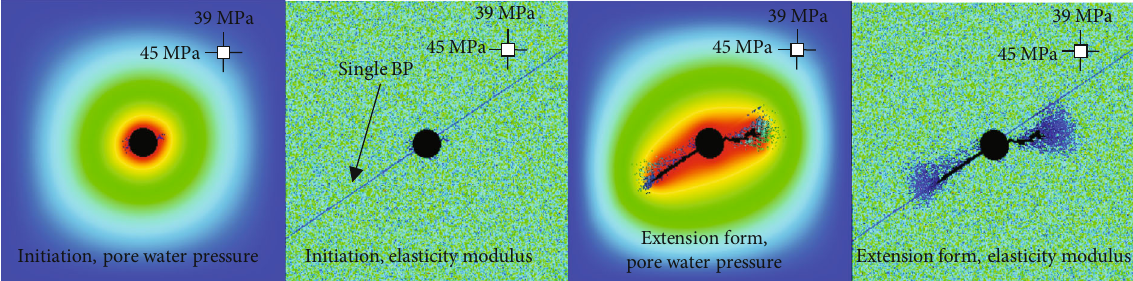
Figure 6: Interaction between single BP and